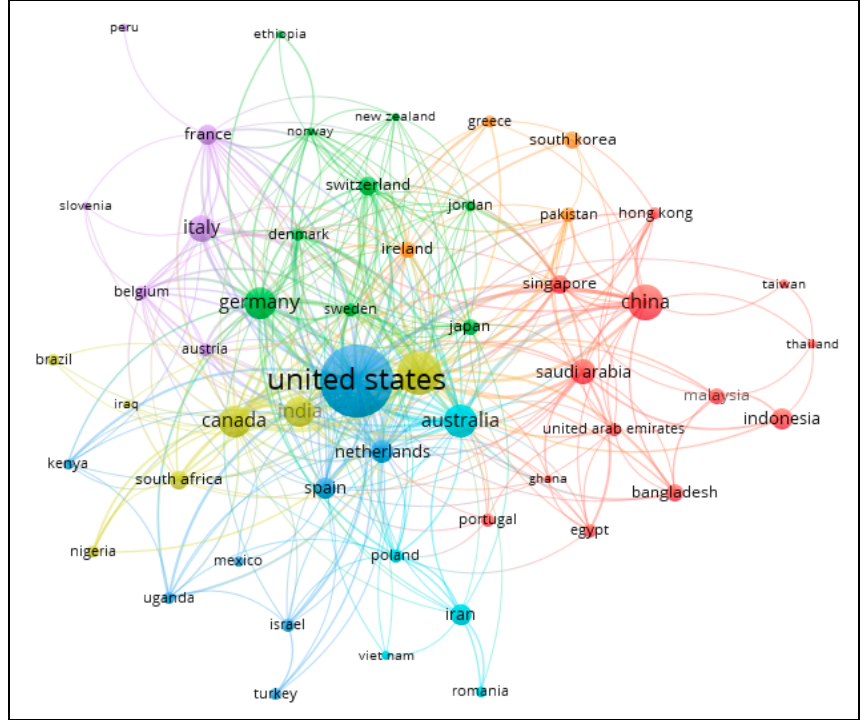
Figure 3. Co-authorship analysis at the country level. (Note: Seven clusters were identified with the largest one (red in color) with 17 countries and regions; see the text for more details) Co-citation analysis was performed based on the cited references using VOSviewer.